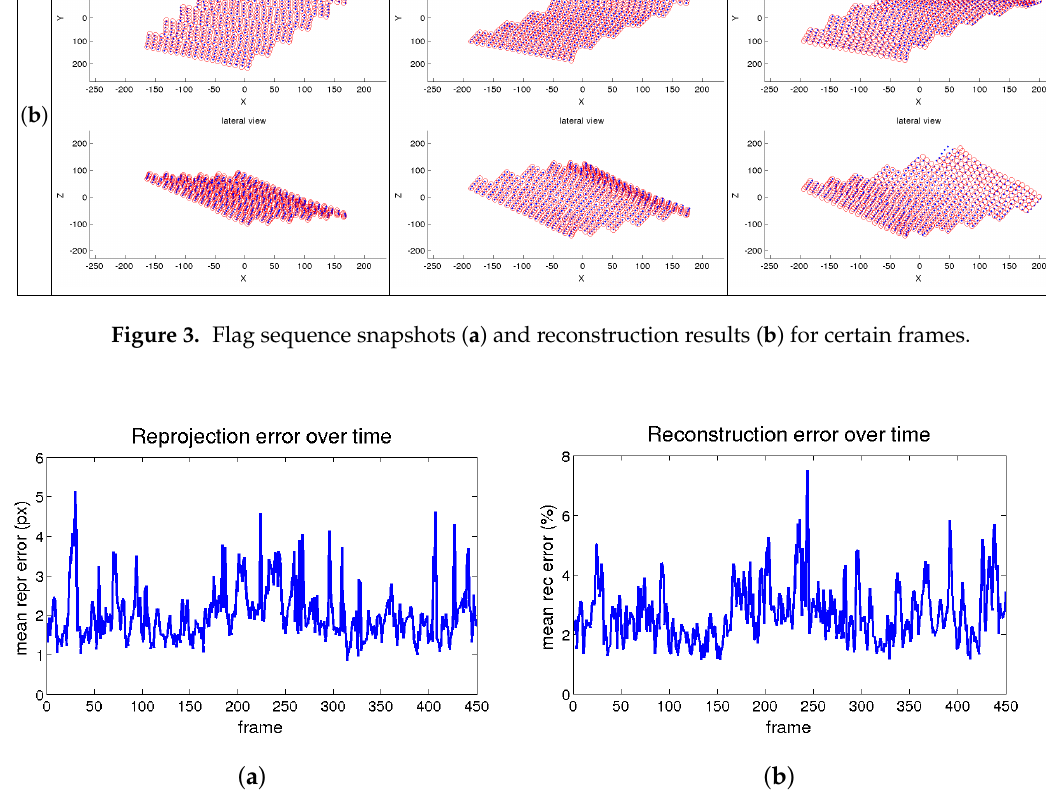
Figure 4. Flag sequence error figures through time. ( a ) The reprojection error and ( b ) the 3D reconstruction